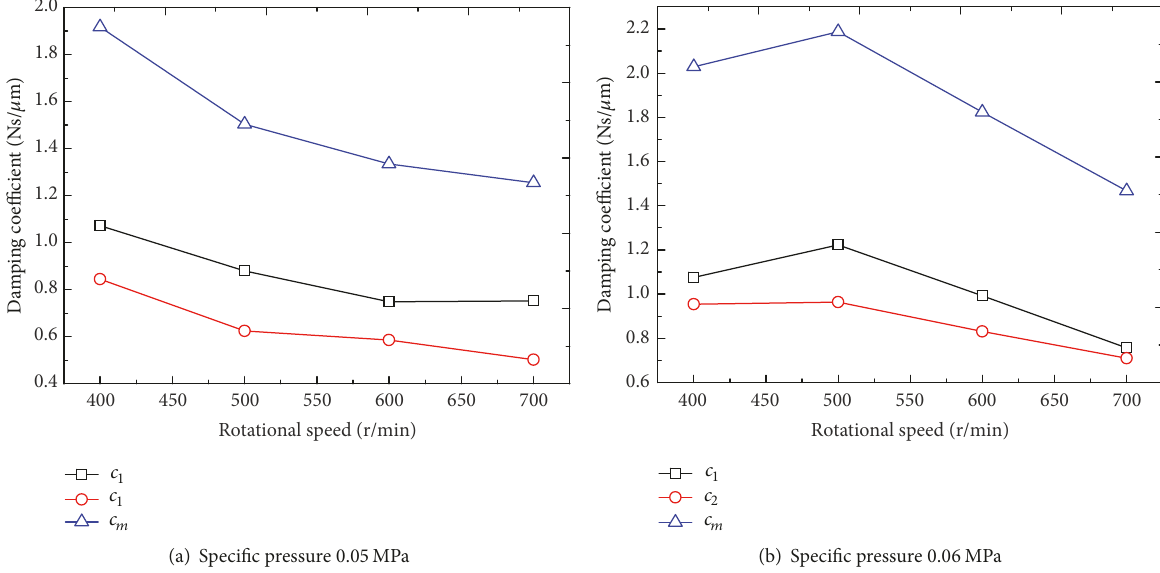
Figure 12: Damping coefficient identified at different loads and